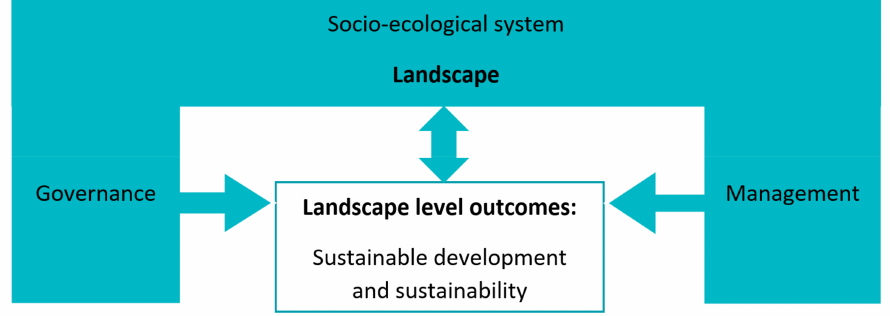
Figure 3. Integration of governance and management for ILA implementation within a socio- ecological system (Source: own elaboration by